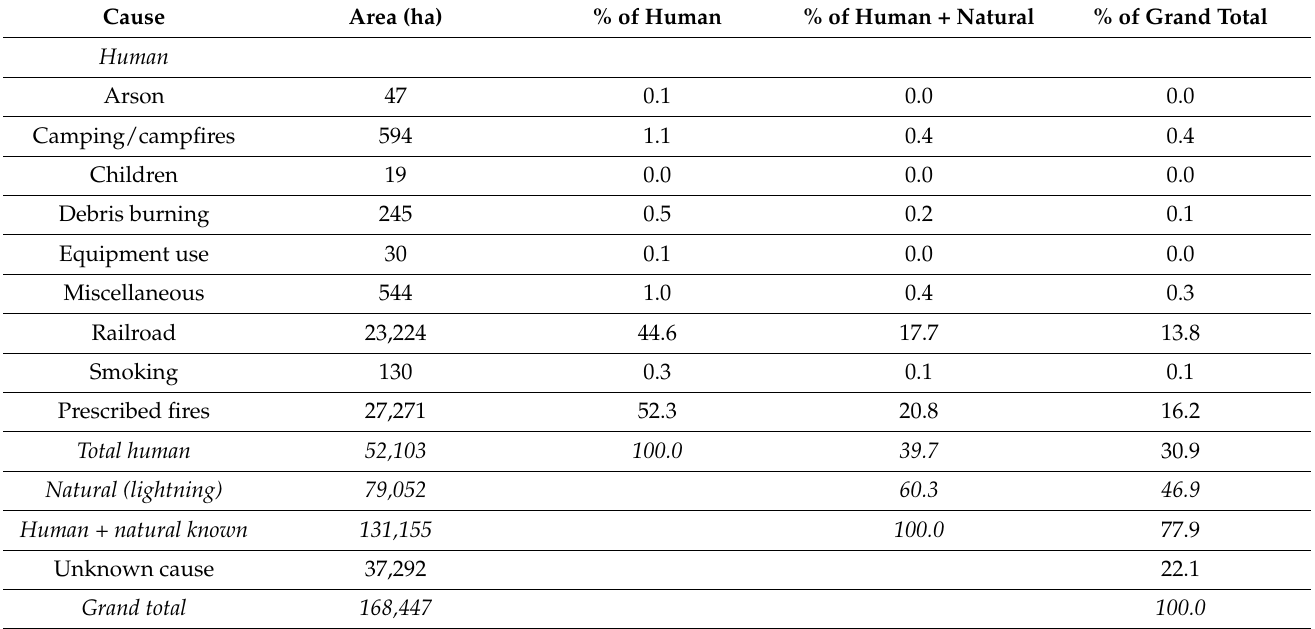
Table 3. Causes of vegetation fires in the San Juan Mountains from 1980 to